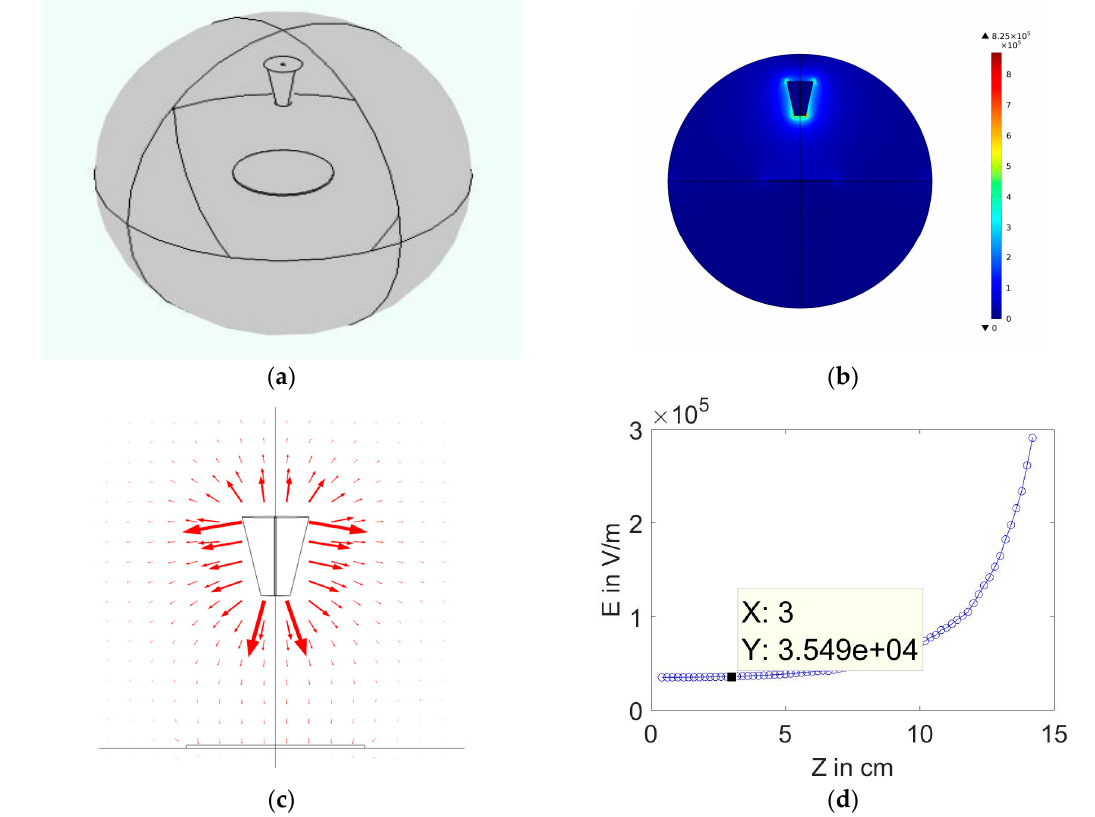
Figure 4. ( a ) Designed cone feeder in COMSOL software, ( b ) Electric field distribution surrounding to the conical spinnerte at (d = 15 cm, V = 15 kV, cone dimensionl base 3 cm, height 8 cm), ( c ) Mapping of electric field lines, and ( d ) Variation of electric field magnitude along z-axis, which presents the distance between the feeder and collector.